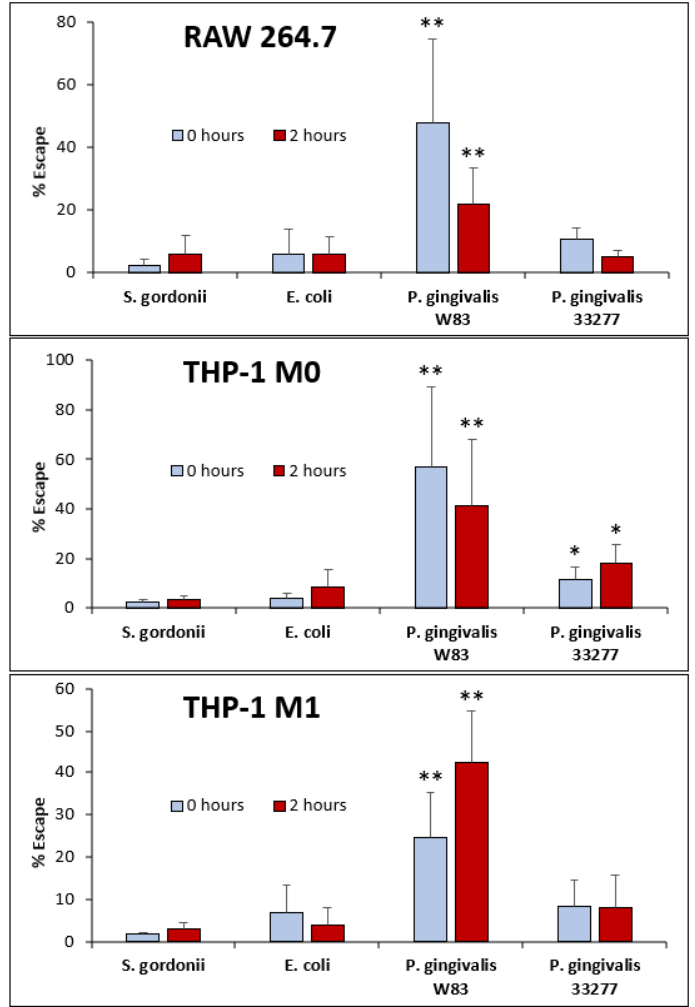
Figure 5. Bacterial Escape % shown at 0 and 2 h across three cell lines: RAW 264.7, THP-1 M0, and THP-1 M1 for bacterial strains S. gordonii , E. coli , and P. gingivalis W83 and 33277. Each value is